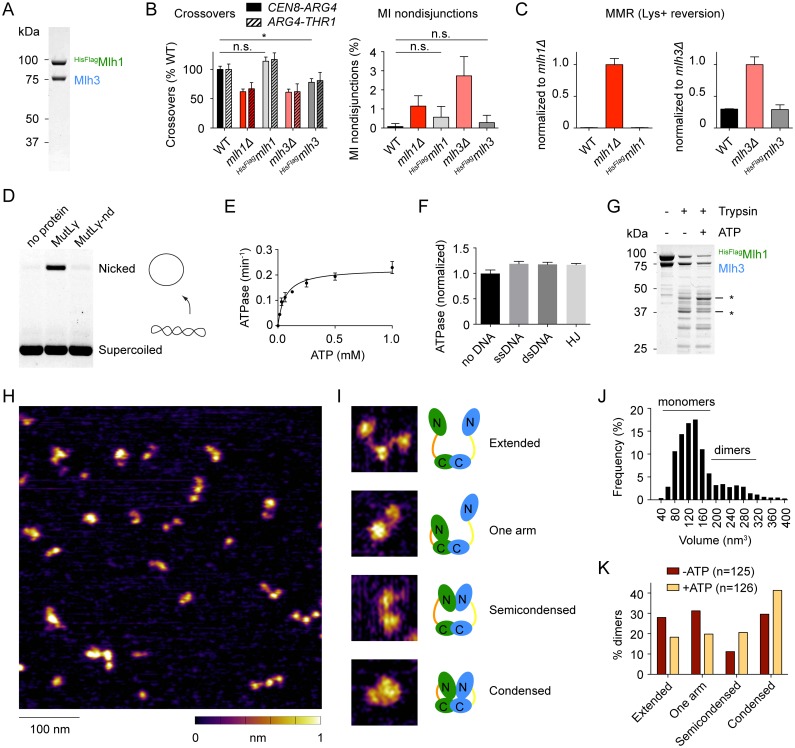
Purification and in vitro characterization of the S. cerevisiae MutLγ complex.A. Purification of affinity-tagged S. cerevisiae Mlh1-Mlh3 heterodimers from baculovirus-infected insect cells. A Coomassie-stained SDS-PAGE gel is shown; 2 μg of protein was loaded. B. Effects on meiotic recombination of N-terminal tagging of Mlh1 (HisFlagmlh1) and Mlh3 (HisFlagmlh3). Crossover frequencies in two test intervals (CEN8-ARG4 and ARG4-THR1) and MI nondisjunctions frequencies were measured by the spore-autonomous fluorescence assay (described in detail in Fig 4 below; values for mlh1Δ and mlh3Δ are reproduced from Fig 4 for comparison). Error bars represent standard errors for crossovers and 95% confidence interval of the proportion for MI nondisjunction. Statistically significant differences are indicated with asterisks (*, p<0.05). Selected non-significant differences are highlighted (n.s.). C. Effects on MMR of N-terminal tagging of Mlh1 and Mlh3. Graphs show Lys+ reversion frequencies normalized to the wild-type value. See text associated with Fig 5 for details on the assay. Error bars are standard deviation of the mean (n = 3–6). Values for mlh1Δ and mlh3Δ are reproduced from Fig 5 for comparison. D. DNA cleavage activity of MutLγ. Reactions containing 100 nM MutLγ and 5.7 nM pUC19 plasmid were incubated at 30°C for 1 hour, then stopped, separated on an agarose gel, and stained with ethidium bromide. The nuclease-dead mutant (MutLγ-nd) carries the active site mutation D523N on Mlh3. E. Michaelis-Menten data of MutLγ ATPase activity (Vmax = 0.225 ± 0.012 min-1; Km = 0.064 ± 0.013 mM; mean ± SE). Error bars show the range from two independent experiments. F. Effect of DNA on the ATPase activity of MutLγ. Substrates are identical to the ones used for binding assays in Fig 2C (see Materials and methods). Reactions contained 280 nM MutLγ with 4.8 pg DNA (2, 1 and 0.5 μM ssDNA, dsDNA and HJ, respectively). Error bars show the standard deviations from three independent determinations. Data were normalized to the mean of the ATPase activity in the absence of DNA (kcat = 0.112 ± 0.005 min-1). G. Partial proteolysis of MutLγ. A Coomassie-stained SDS-polyacrylamide gel is shown. Asterisks indicate some of the protein fragments that are different in the presence or absence of ATP (5 mM). H. AFM imaging of MutLγ. The image illustrates the heterogeneity of the size and configurations of MutLγ particles observed. I. Examples of the four configurations of dimeric MutLγ particles observed by AFM. The inference of the domains involved in dimerization is based on the characterization of other MutL proteins, which show that the C-terminal domains dimerize independently of ATP, while the N-terminal domains dimerize upon ATP binding [52, 53]. Which subunit is folded in the ‘one arm’ configuration is not known; the cartoon showing Mlh1 folded is intended only as an illustration. J. Volume analysis of MutLγ particles. The predicted volume of the heterodimer (175 kDa) is 257 nm3 according to the equation: Vc = (M0/N0)(V1+dV2), where M0 is the molecular weight, N0 is Avogadro’s number, V1 and V2 are specific volumes for protein (0.74 cm3 g-1) and water (1 cm3 g-1) and d is the extent of protein hydration (0.4 g H2O/g protein) [76]. K. Classification of MutLγ particles in the absence and presence of 1 mM ATP. A cutoff of 170 nm3 was chosen to classify particles as dimers (see panel J). The difference between distributions is statistically significant by G test, p = 0.0082.